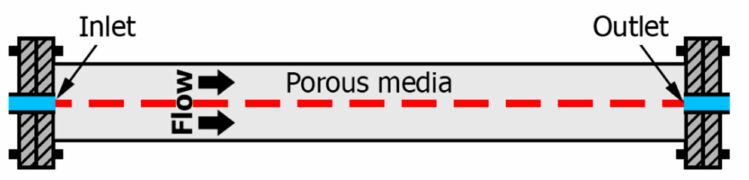
Figure 5. Schematic representation of the domain used in the 1D numerical simulation. Initial molar concentrations for uranium and minerals were taken from the described experimental data according to Equation (9): c UO 3 ( x , 0 ) = 0.0016, c UO 2 ( x , 0 ) = 0.0016 and c Mineral ( x , 0 ) = 0.274